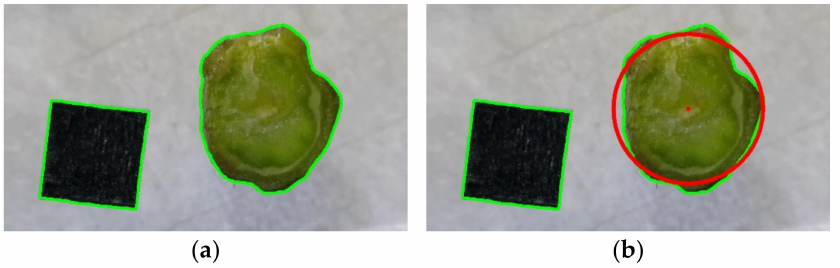
Figure 6. The image processing results ( a ) Find contours; ( b ) Fitting